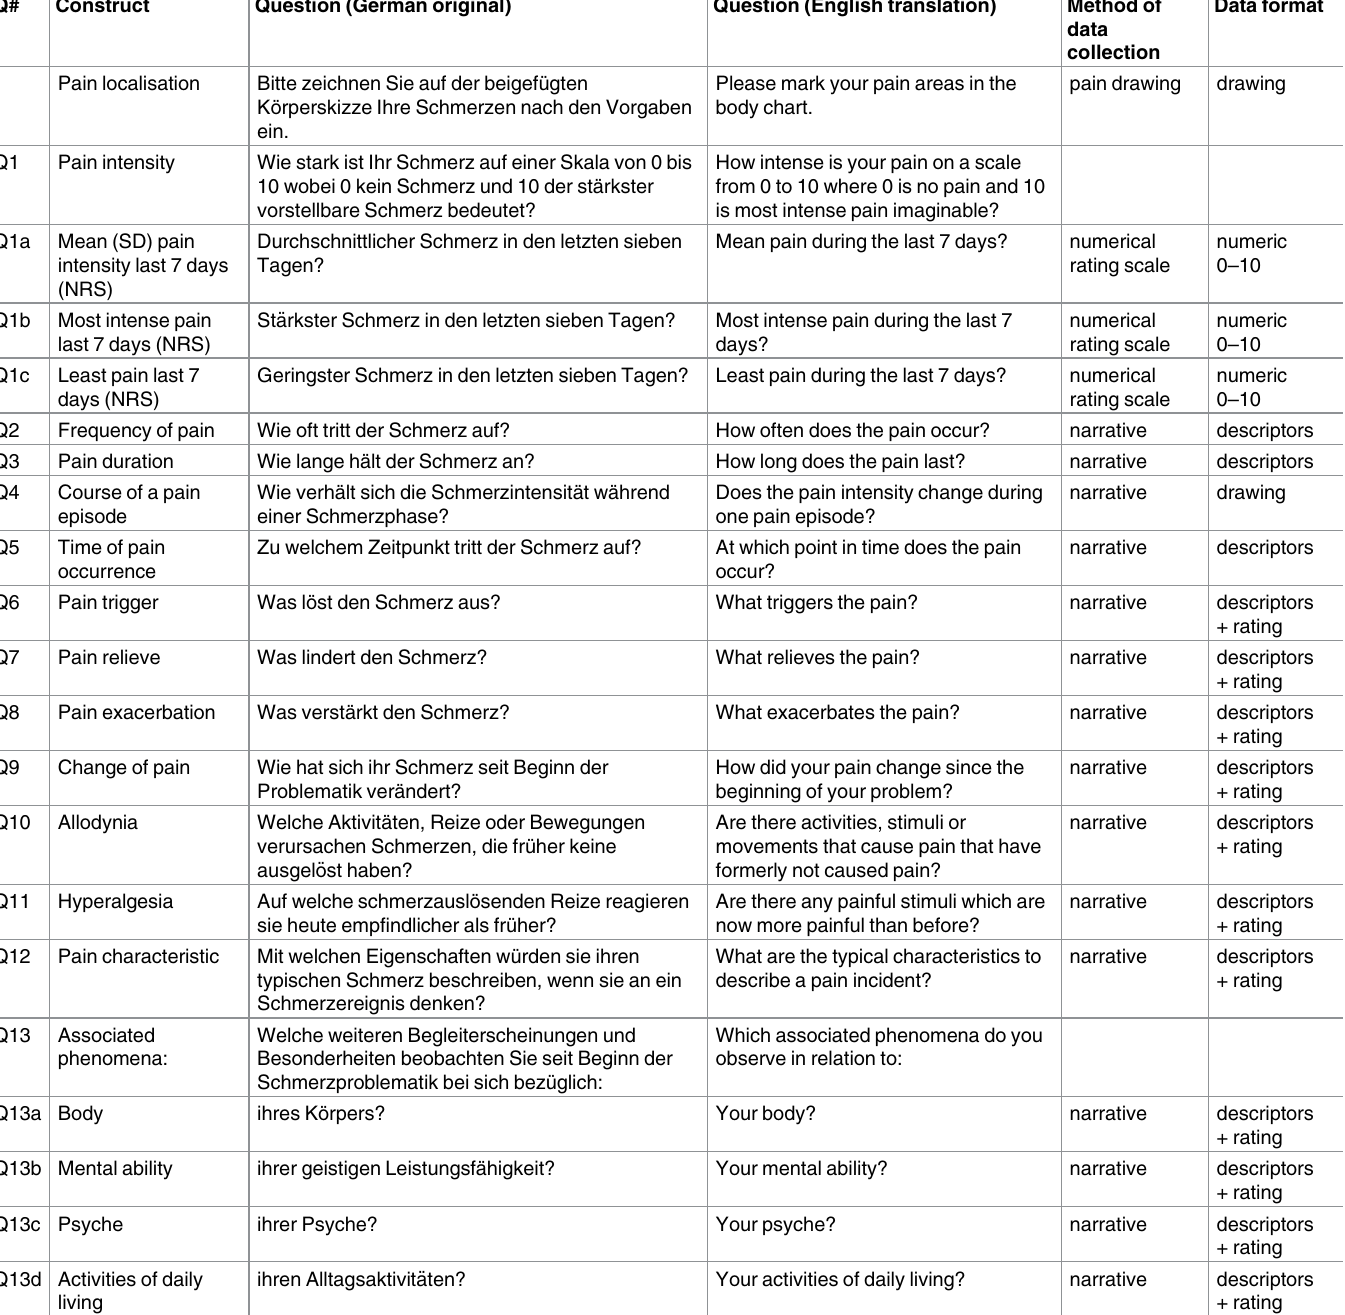
Table 2. List of questions, method of data collection and data